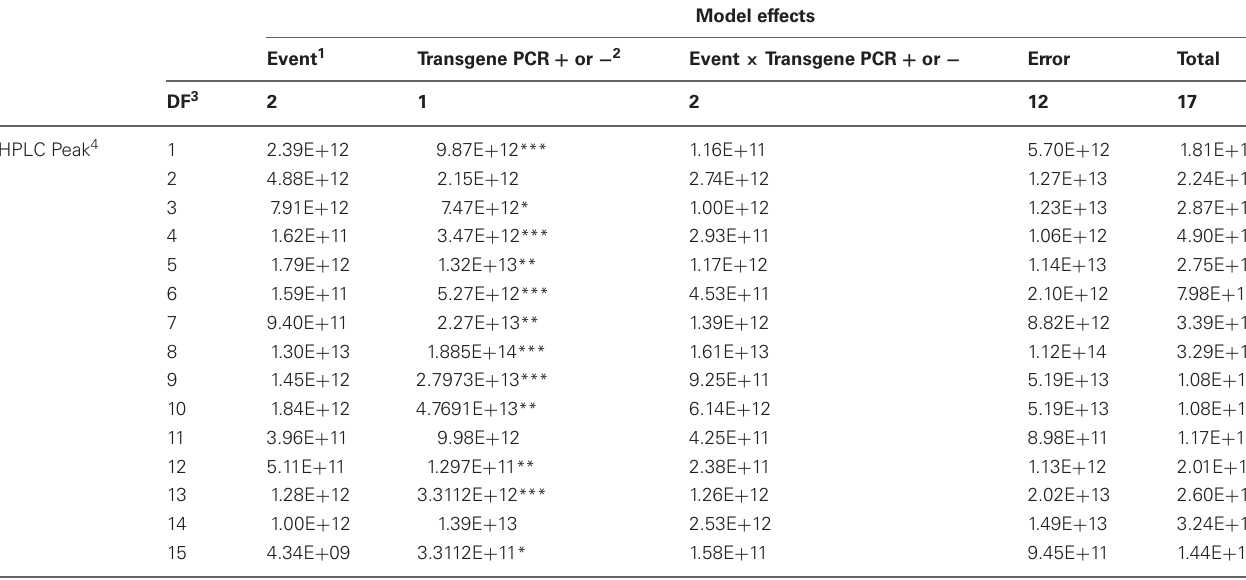
Table 3 | ANOVA Table showing the sums of squares for the mean HPLC peak areas of maize zein proteins in maize seed samples positive or negative for the soybean ferritin